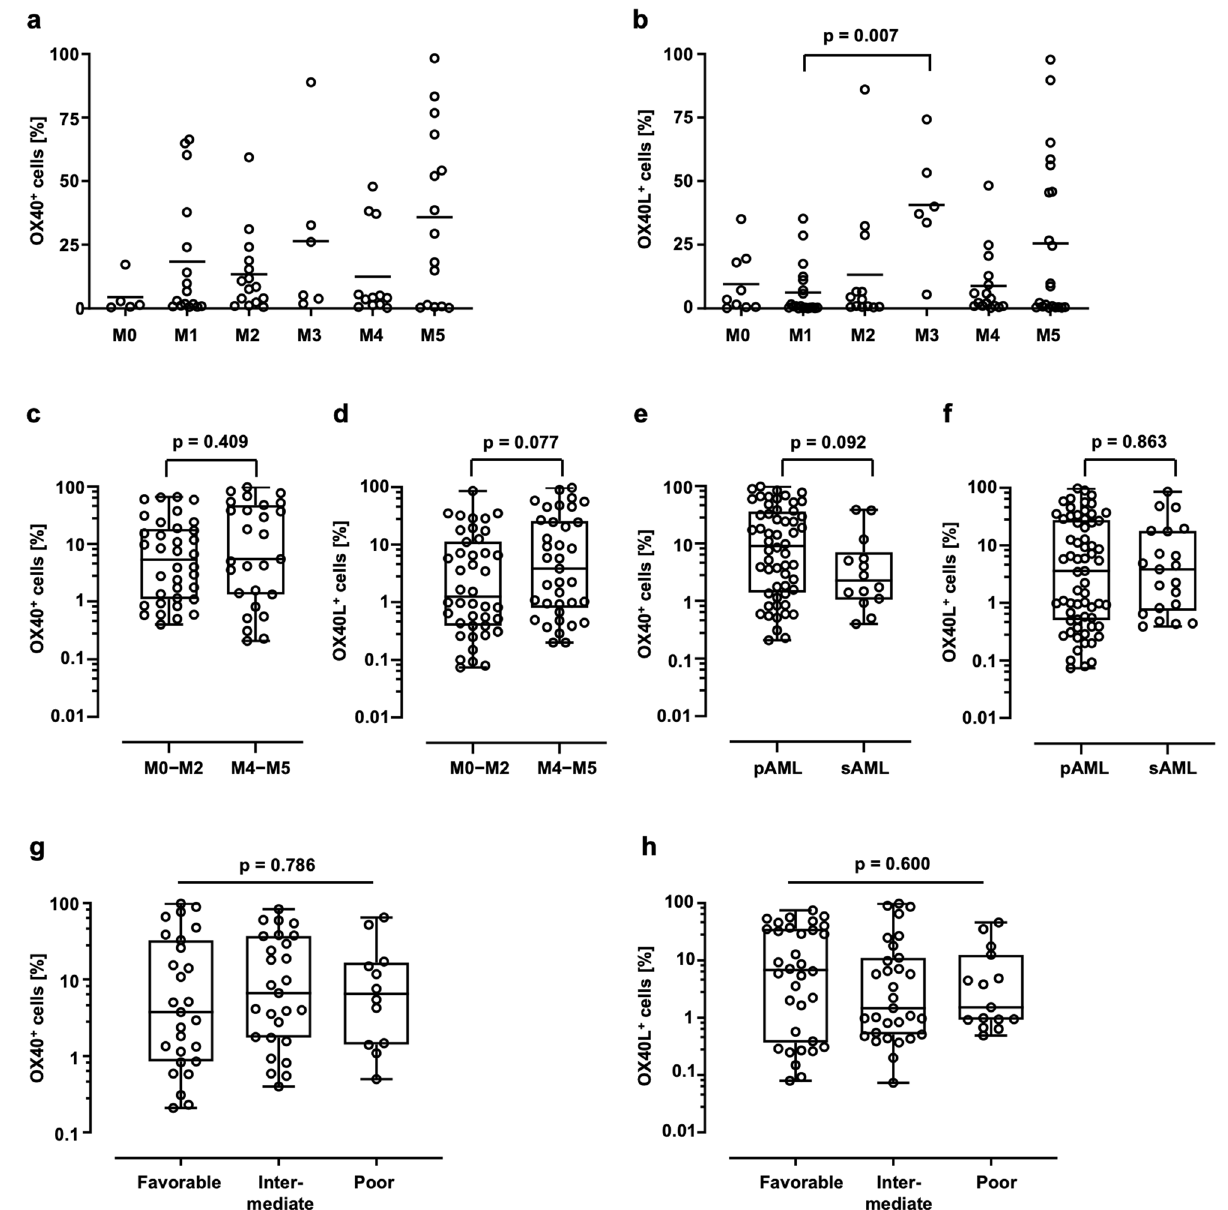
Figure 2. OX40 and OX40L expression on primary AML cells and association with clinical parameters. Frequencies of OX40 ( a ) and OX40L ( b ) positive blasts according to the different FAB classifications (single values, median, Kruskal–Wallis test) are showed. The expression of OX40 ( c ) and OX40L ( d ) was analyzed on FAB M0-M2 vs. FAB M4-M5 (min/max whiskers, Mann–Whitney-U test). The expression of OX40 ( e ) and OX40L ( f ) was analyzed primary (pAML) vs. secondary (sAML) AML (min/max whiskers, Mann–Whitney-U test). Distribution of OX40 ( g ) and OX40L ( h ) expression (%) throughout NCCN risk group (min/max whiskers, Kruskal–Wallis test) is